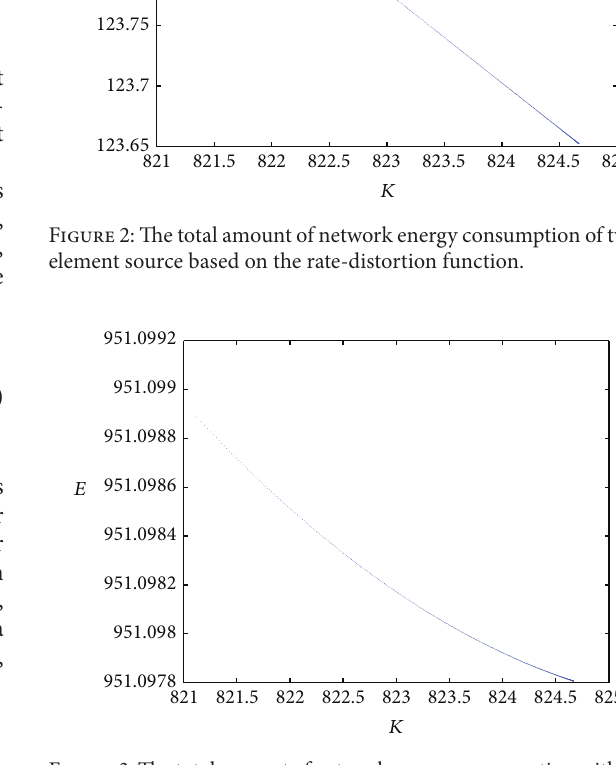
Figure 3: The total amount of network energy consumption without considering the rate-distortion